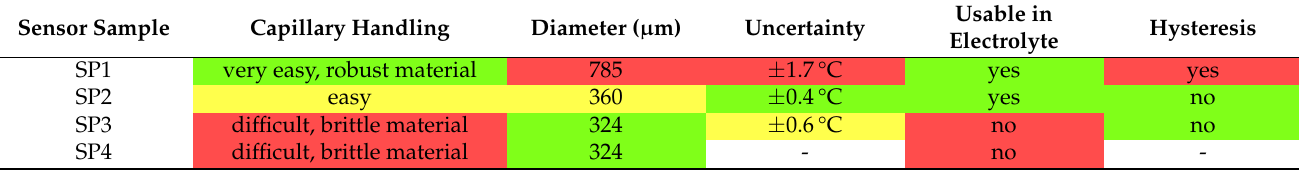
Table 3. Comparison of the different materials tested as capillaries in the electrolyte. SP1: optical fiber in PEEK capillary, single-point mounting; SP2: optical fiber in fused silica tube with polyimide coating, single-point mounting; SP3: optical fiber in fused silica tube, removed polyimide coating, single-point mounting; SP4: optical fiber in fused silica tube, removed polyimide coating, double-point mounting. The colors green, yellow and red rank the different